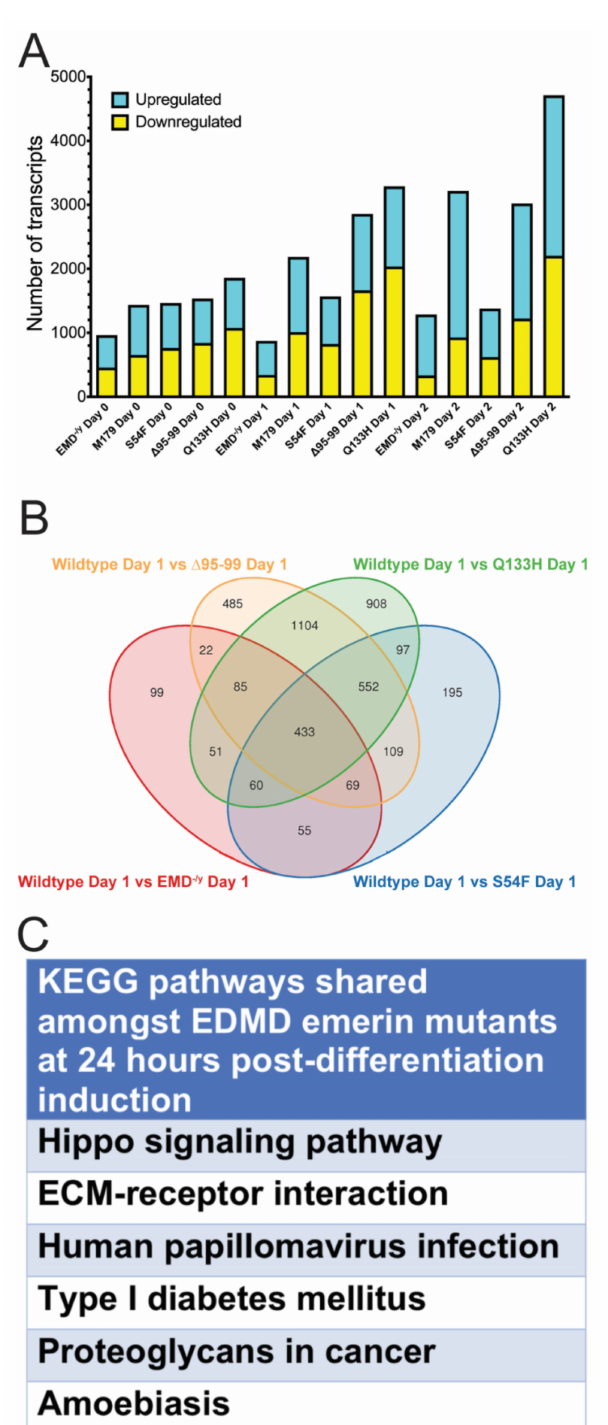
Figure 6. Significant changes in the transcriptome are seen during di ff erentiation of EDMD mutant myogenic progenitors. ( A ) Di ff erentially expressed transcripts were identified by comparing wildtype progenitors to EMD − / y myogenic progenitors or each EDMD mutant myogenic progenitor at each di ff erentiation day. Blue —upregulated transcripts; Yellow —downregulated transcripts. ( B ) Venn diagrams illustrating di ff erentially expressed genes shared between one or more EDMD mutant progenitor one day after di ff erentiation induction. ( C ) KEGG pathway analysis showing pathways enriched in EDMD emerin mutants, but not present in + EMD progenitors one day after di ff erentiation